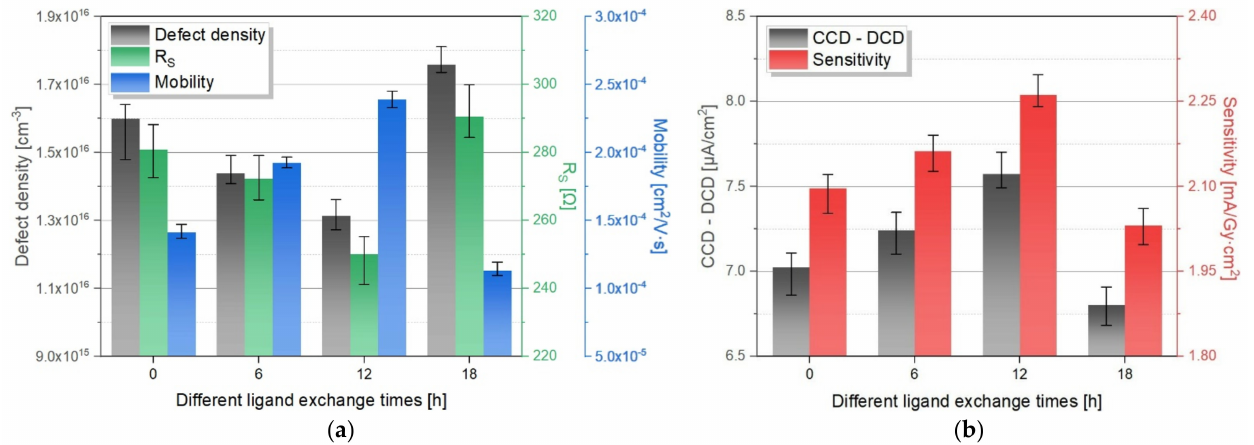
Figure 9. ( a ) The mobility and defect density of the proposed detectors with different pyridine ligand exchange times, and ( b ) the evaluated parameters (R S , CCD—DCD, and sensitivity) of the detectors based on P3HT:PC 71 BM active layer with FAPbBr 3 PeQDs (1 mg) at (0, 6, 12, and 18) h ligand exchange